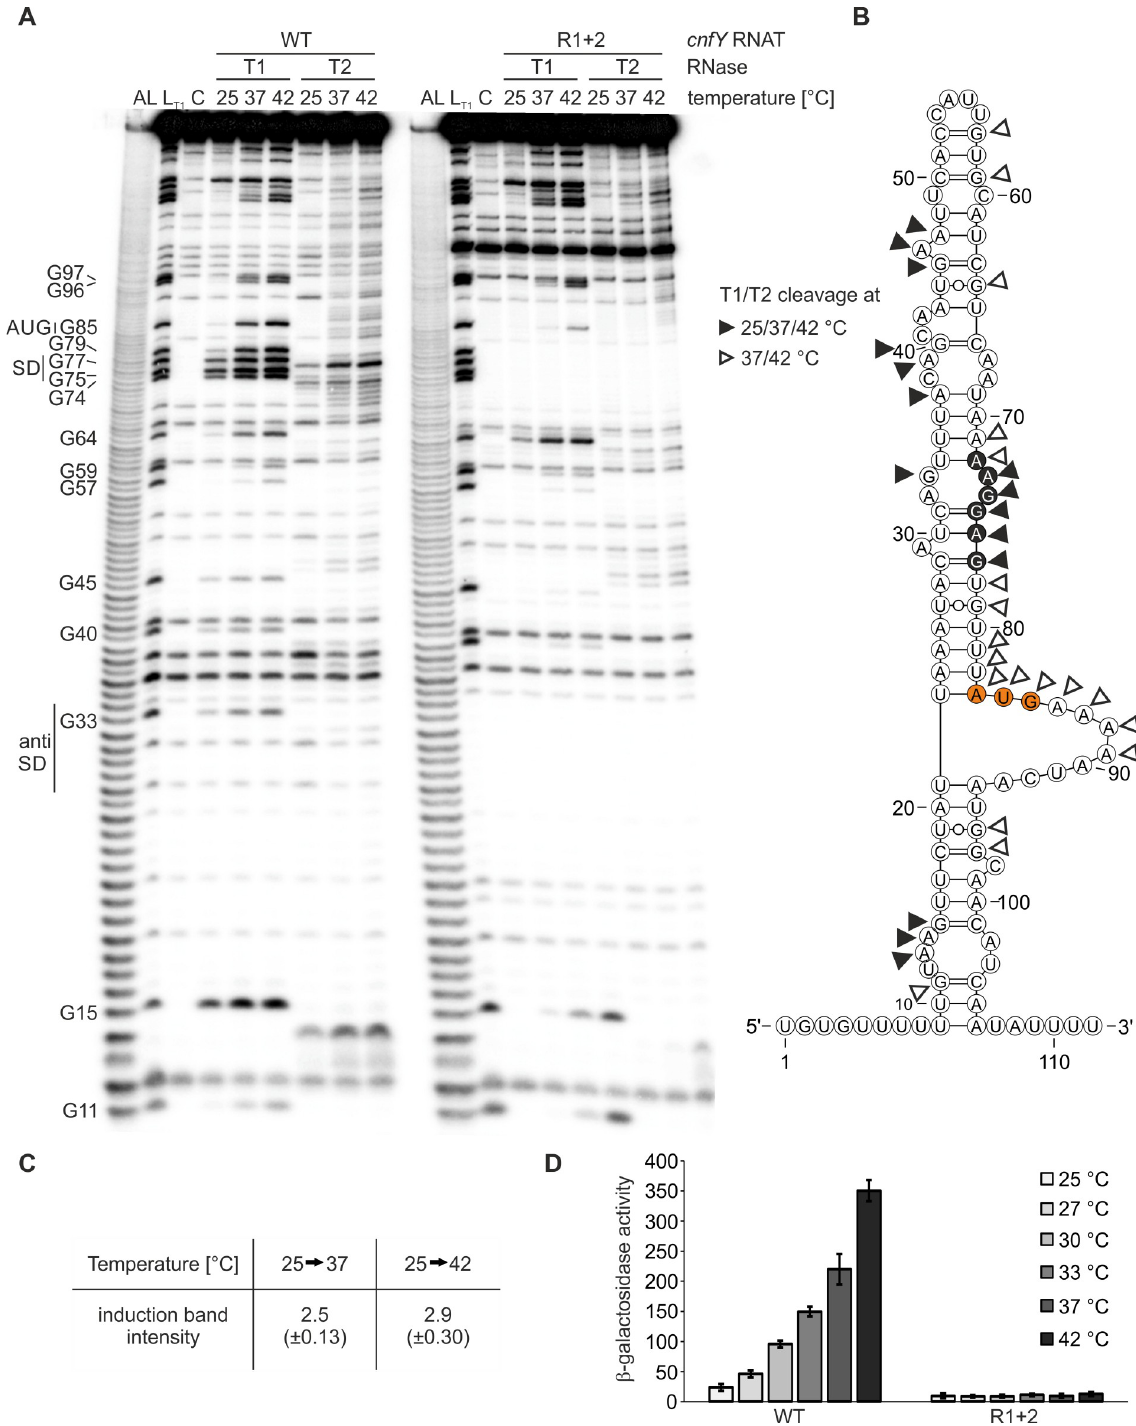
Fig 6. The cnfY RNAT undergoes a structural conversion in response to temperature. (A) Enzymatic structure probing of the cnfY RNAT (wild type (WT, pBO4465)) and R1+2 variant (pBO4466)) at 25, 37 and 42˚C. In vitro transcribed RNA was radiolabeled prior to enzymatic digestion with RNase T1 (0.0025 U) and RNase T2 (0.056 U) at the indicated temperatures. Lane L: alkaline ladder, lane L T1 : RNase T1 cleavage in sequence buffer at 37˚C, lane C: RNA treated with water instead of RNase served as control. (B) PARS-derived secondary structure of the cnfY RNAT [18] at 25˚C. Nucleotides cleaved by RNase T1/T2 at all three temperatures or exclusively at 37 and 42˚C are indicated. Nucleotides of the SD region and the AUG start codon are colored in black and orange, respectively. (C) Cleavage signals of the SD sequence (nucleotides G74, G75, and G77 cleaved by RNase T1) were quantified by integrated density quantification using AlphaEaseFC software. The mean density